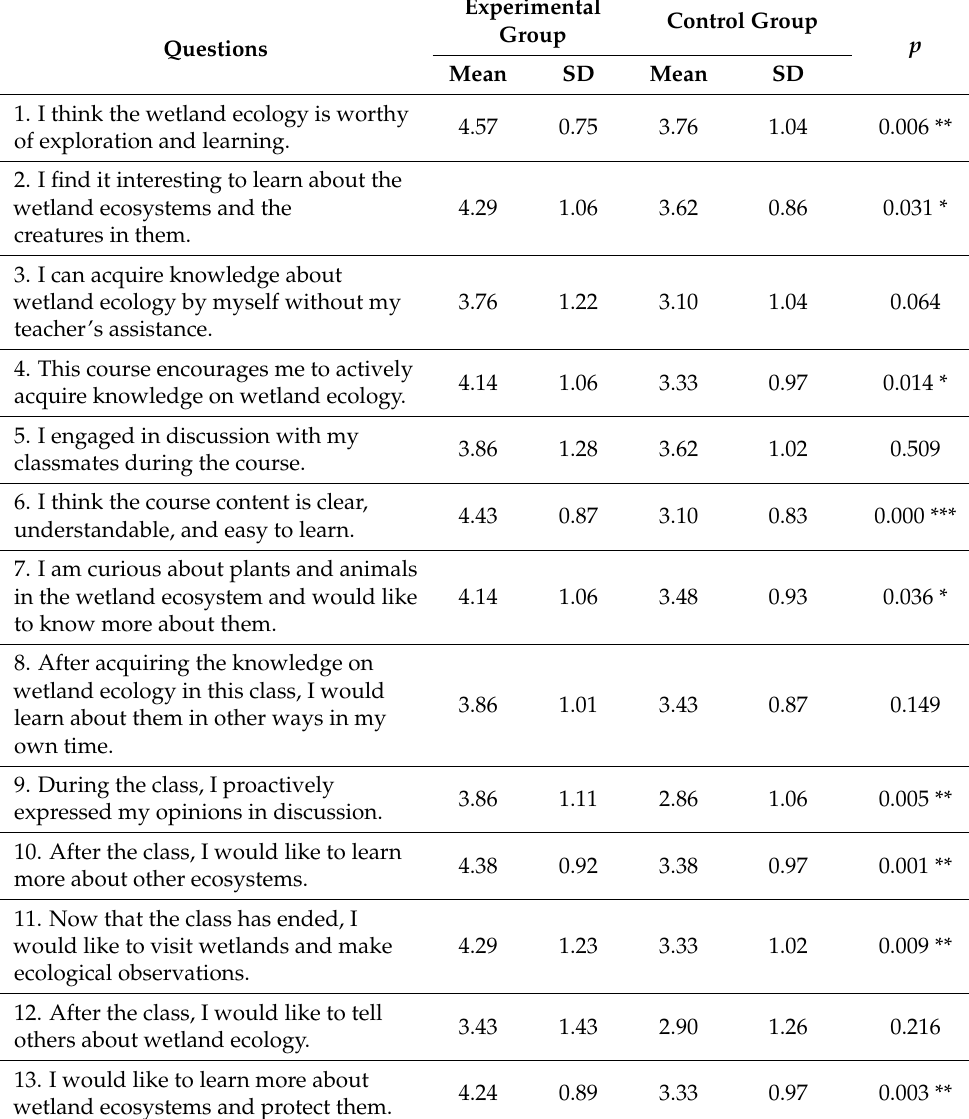
Table 7. Questionnaire and independent sample t -test results on learning motivation for both